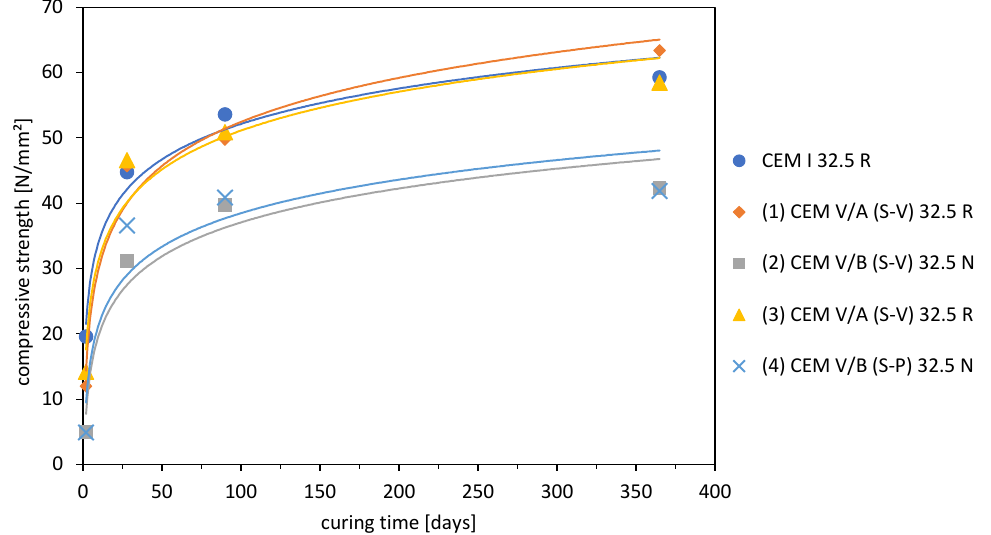
Figure 8. Concrete compressive strength using different cement types at 2, 28, and 90 days of water curing (each value as mean value of 3 individual tests).